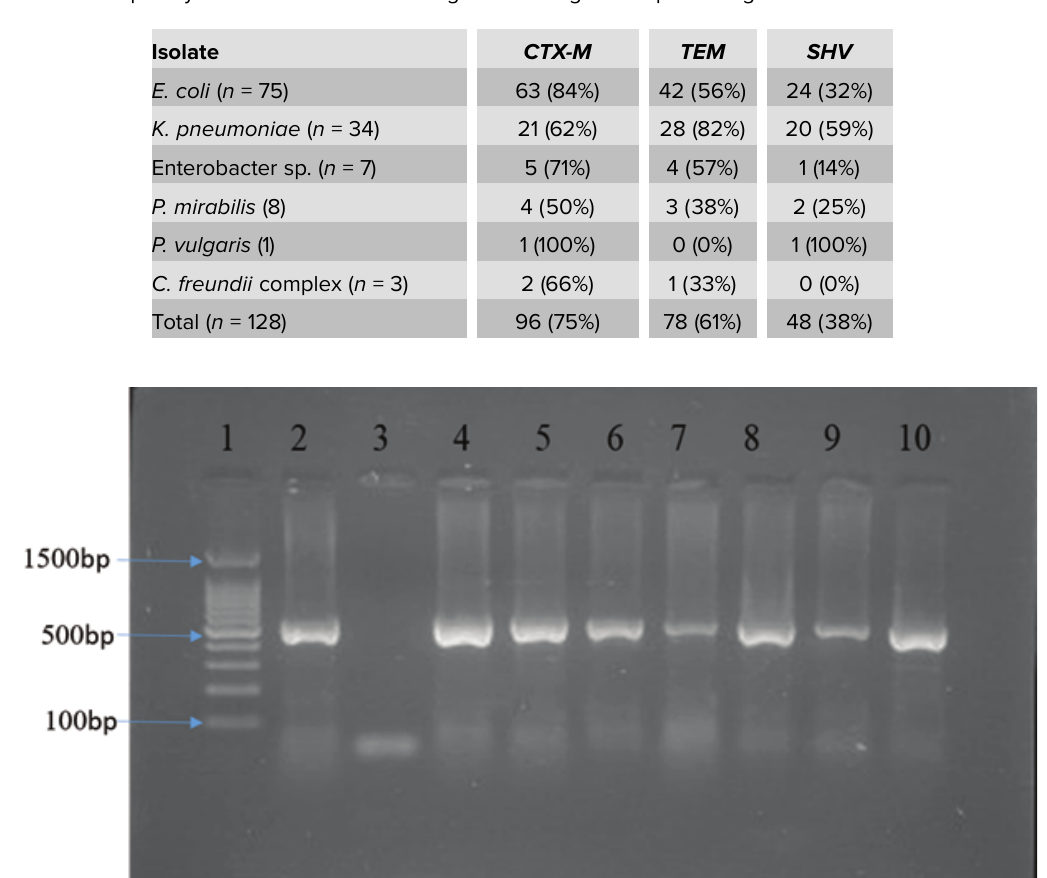
TABLE 4: Frequency of CTX-M TEM and SHV genes among ESBLs-producing Enterobacteriaceae isolates.